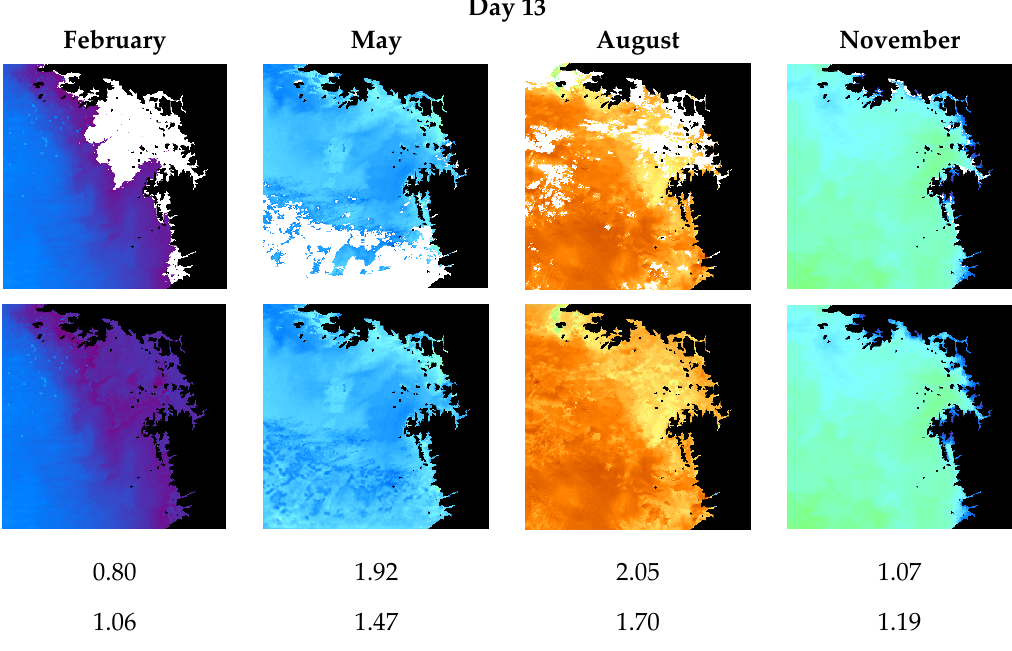
Figure 5. Reconstructed SST data by the GIN.